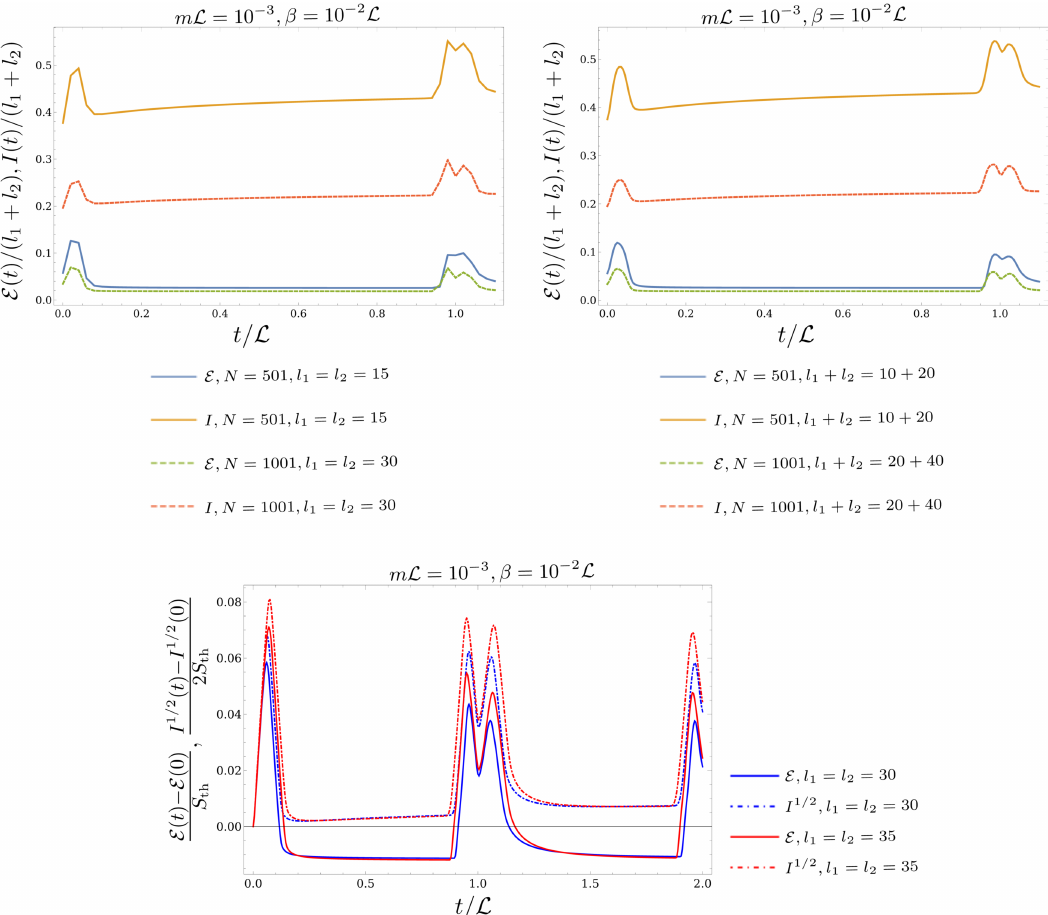
Figure 8 . Time dependency of E and mutual information I are presented in top panel. The top- left and top-right one are for symmetric and non-symmetric subsystems, respectively. The bottom panel demonstrates the time evolution of E and 1 / 2 -Rényi mutual information I (1 / 2) for N =501 .